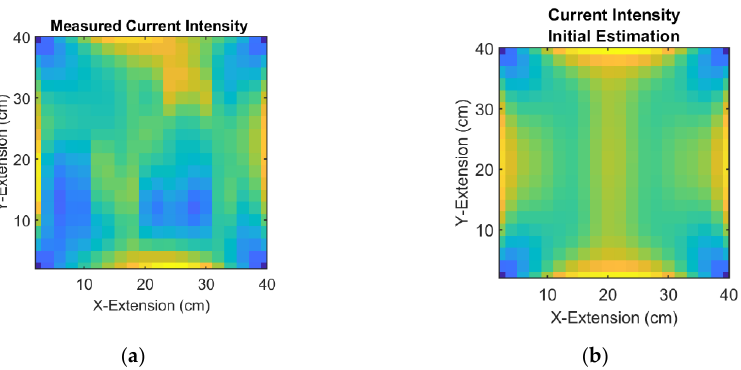
Figure 8. Total current intensity. Yellow color indicates high current intensity, dark blue indicates zero currents: ( a ) The total current intensity I M from measurements of the unknown and inhomogeneous sheet (Figure 7a); ( b ) Total current intensity I E of a homogeneous sheet, which serves as the first estimation here.